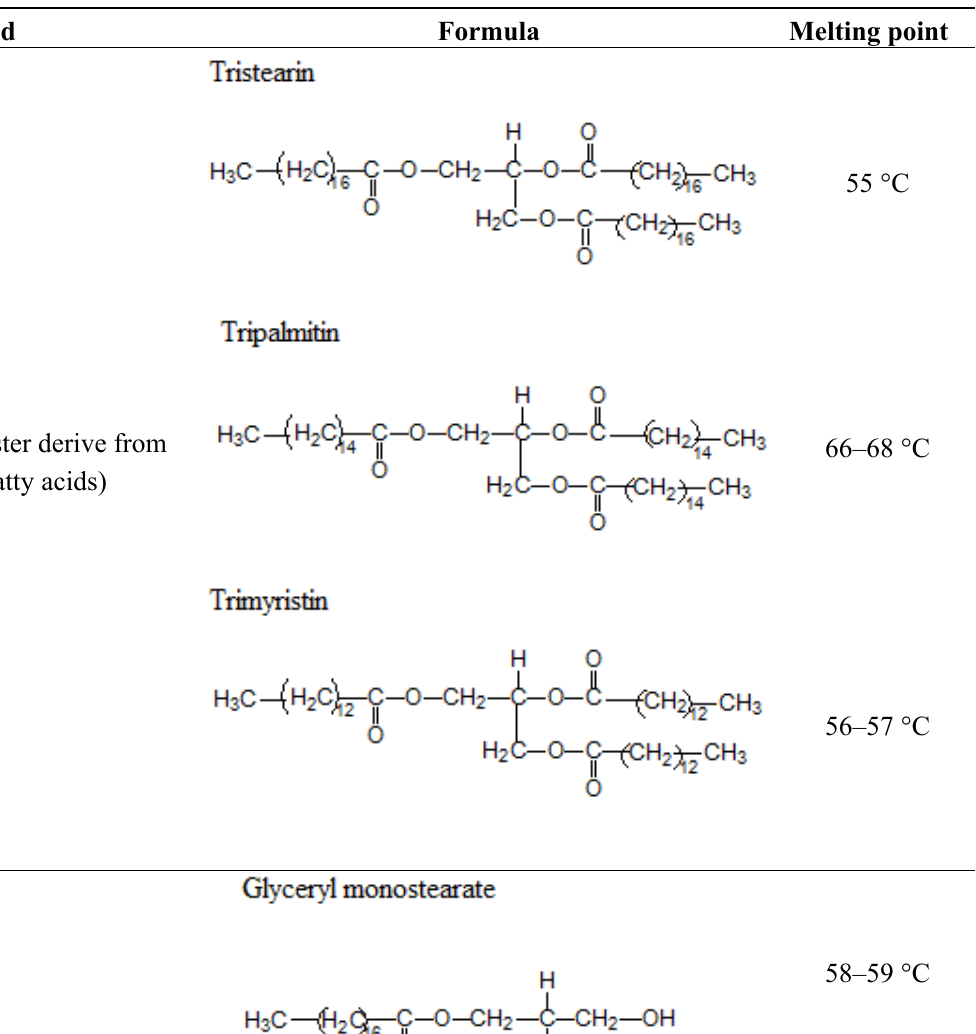
Table 1. Lipids commonly used in the preparation of solid lipid